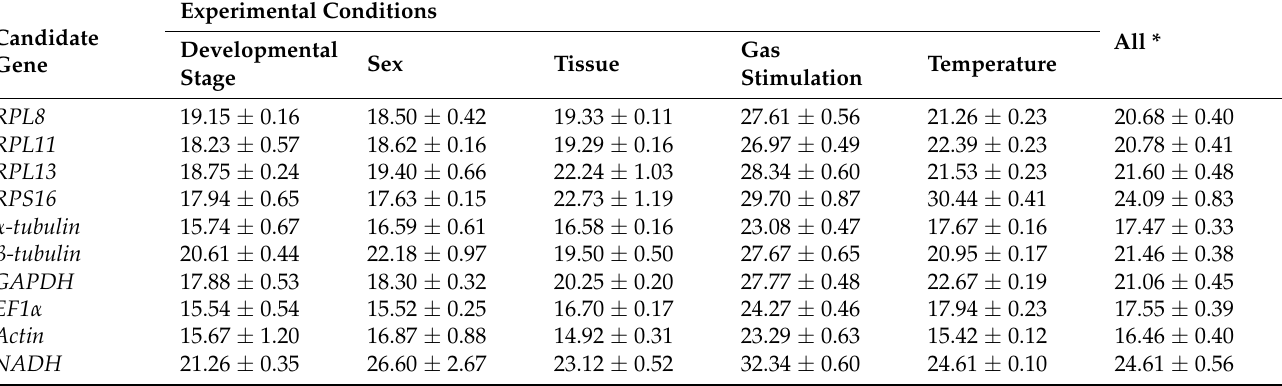
*: The mean cycle threshold (Ct) values (mean ± SE) of each reference gene under five experimental conditions in C. hemipterus